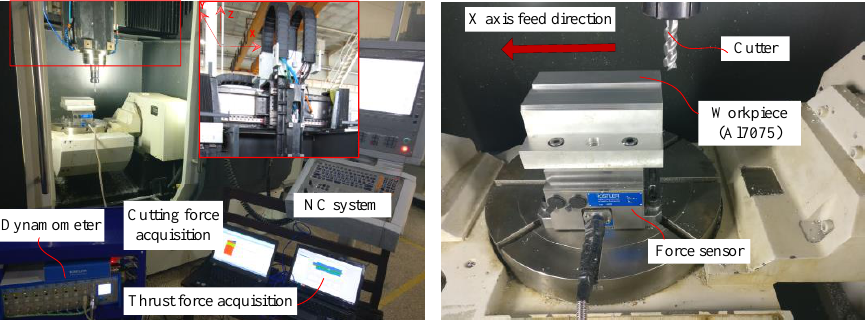
Figure 3. The experimental object for the direct drive feed system. Table 1. The main parameters of direct drive feed system.